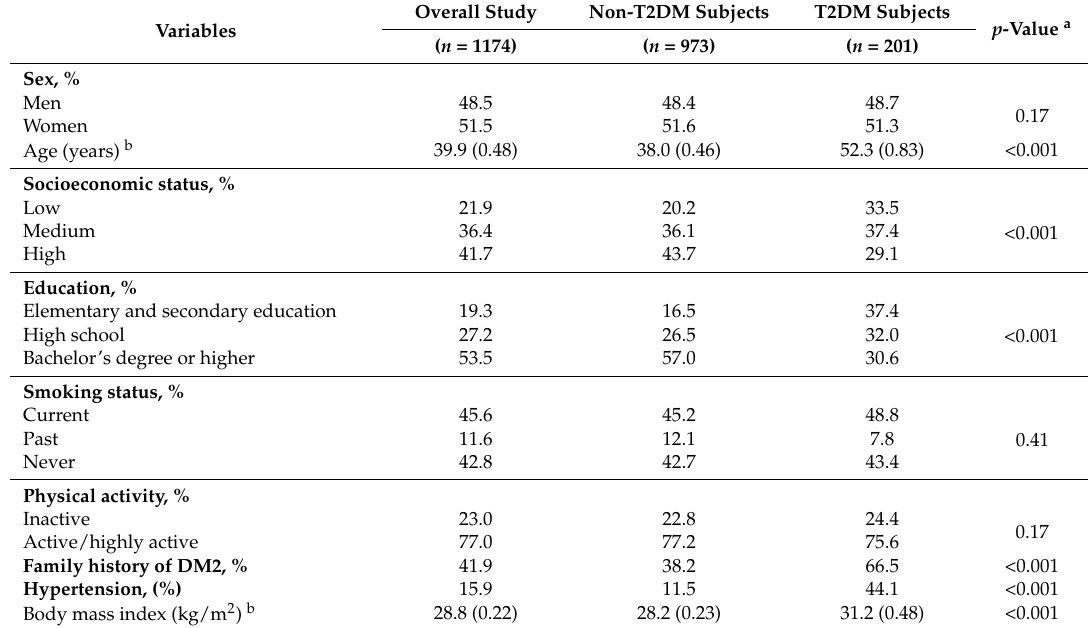
Table 1. Characteristics of the study population: The Diabetes Mellitus Survey of Mexico City,